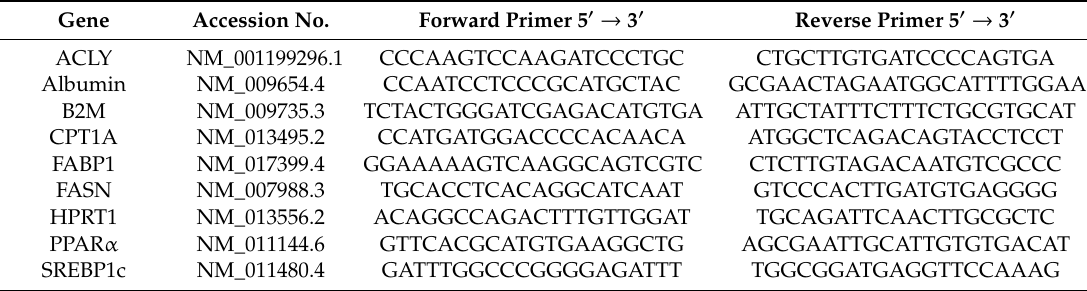
Table 2. List of primers used for semi-quantitative RT-PCR